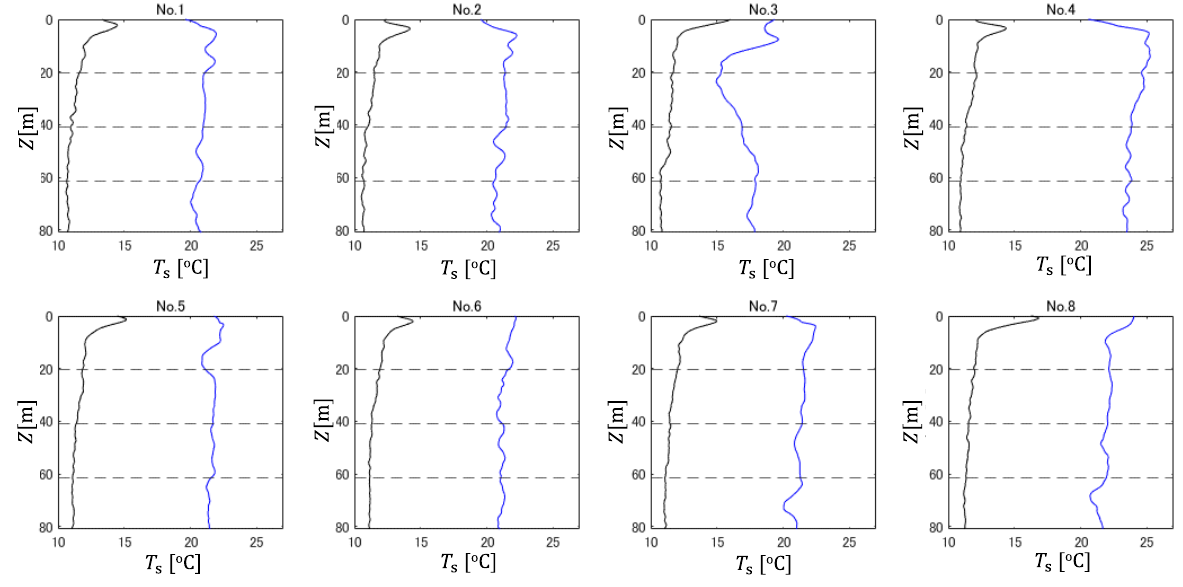
Figure 5. Soil temperature profiles by DTS at eight BHEs: Initial (black) and peak profiles (blue) in each BHE.